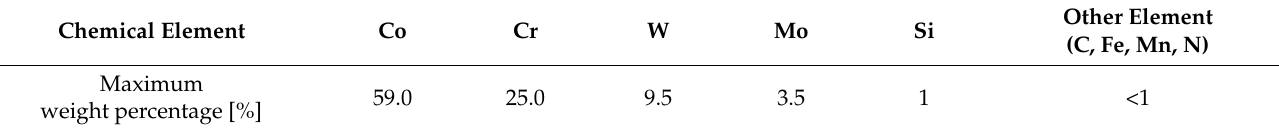
Table 2. Chemical composition of CoCr powder [22].